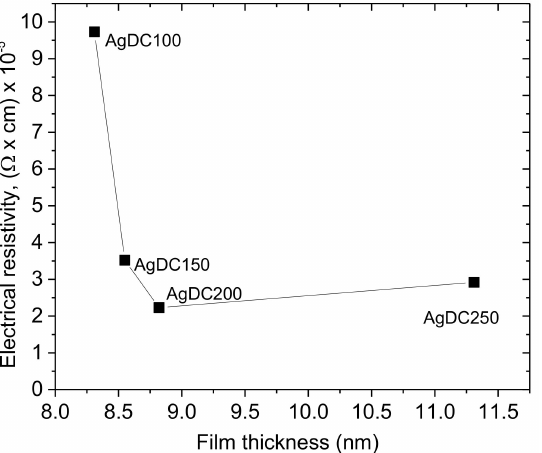
Figure 6. Average resistivity of the Ag thin films obtained at different HiPIMS powers, as a function of measured film